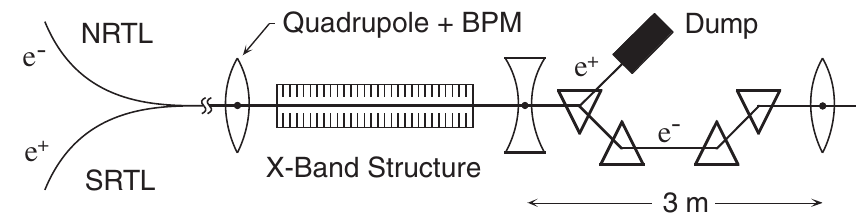
FIG. 10. Schematic of the accelerator structure wakefield measurement facility ASSeT of the